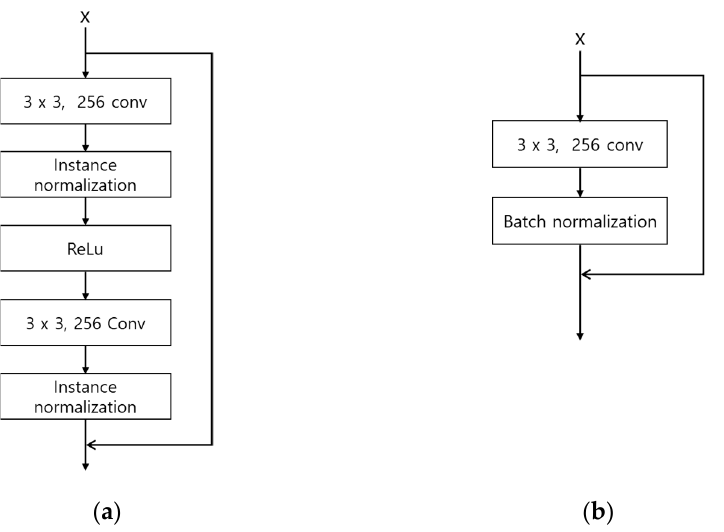
Figure 6. Architectures of original and modified residual blocks: ( a ) residual block in original DeblurGAN; ( b ) a modified residual block in the modified DeblurGAN.